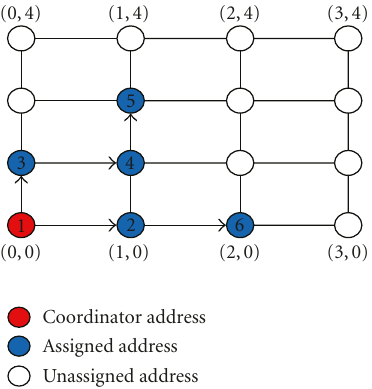
Figure 3: Illustration of incremental address assignment in a two- dimensional subspace partitioning.